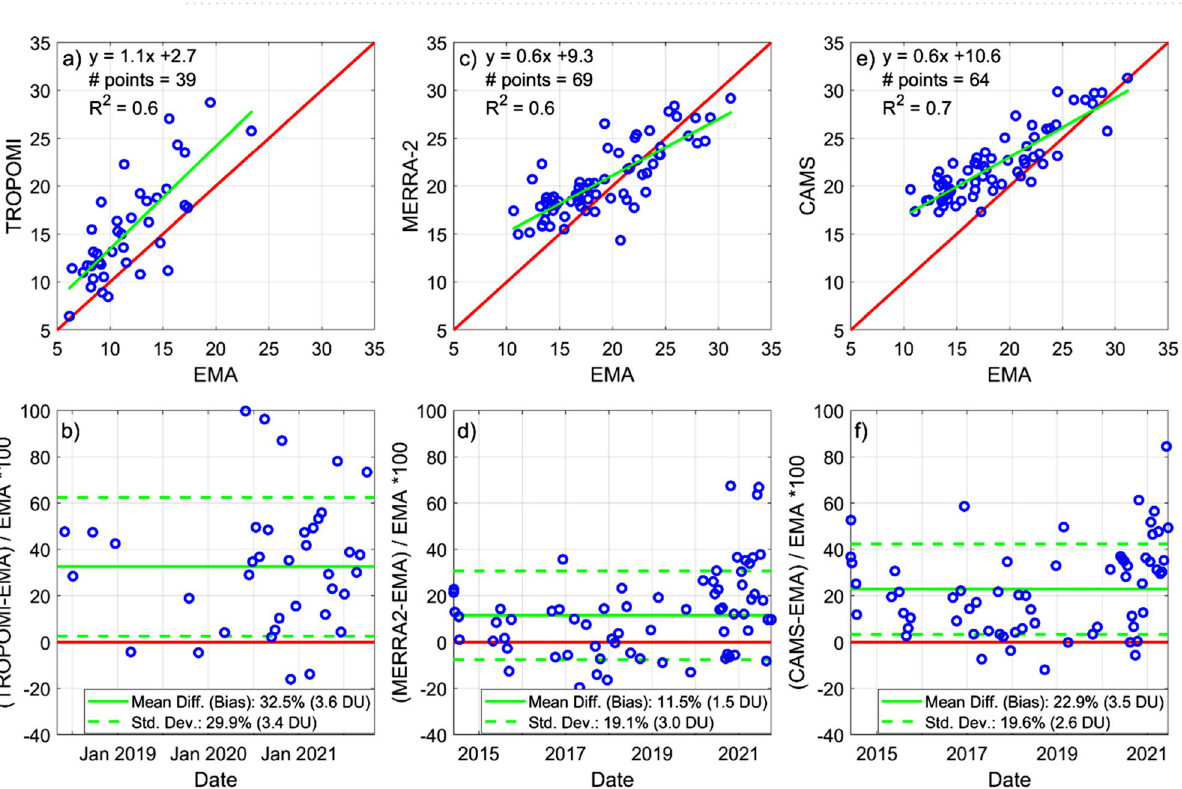
Figure 4. Tropospheric column ozone (TrCO) comparisons between spaceborne observations and ozonesonde measurements taken in Quito, Ecuador (EMA USFQ). 1:1 comparisons are depicted in top panels, while mean percentage differences (or mean biases) are quantified in bottom panels. Ozone soundings were integrated up to 270 hPa to compare against TROPOMI/S5P or up to 100 hPa, to compare against MERRA-2 and